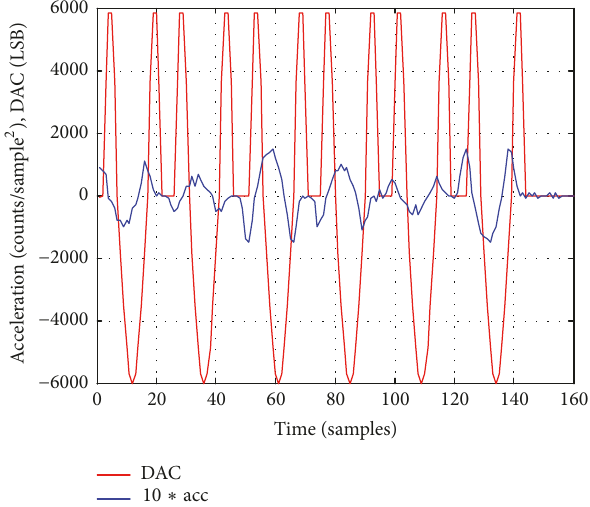
Figure 13: The waveforms of the acceleration and DAC.